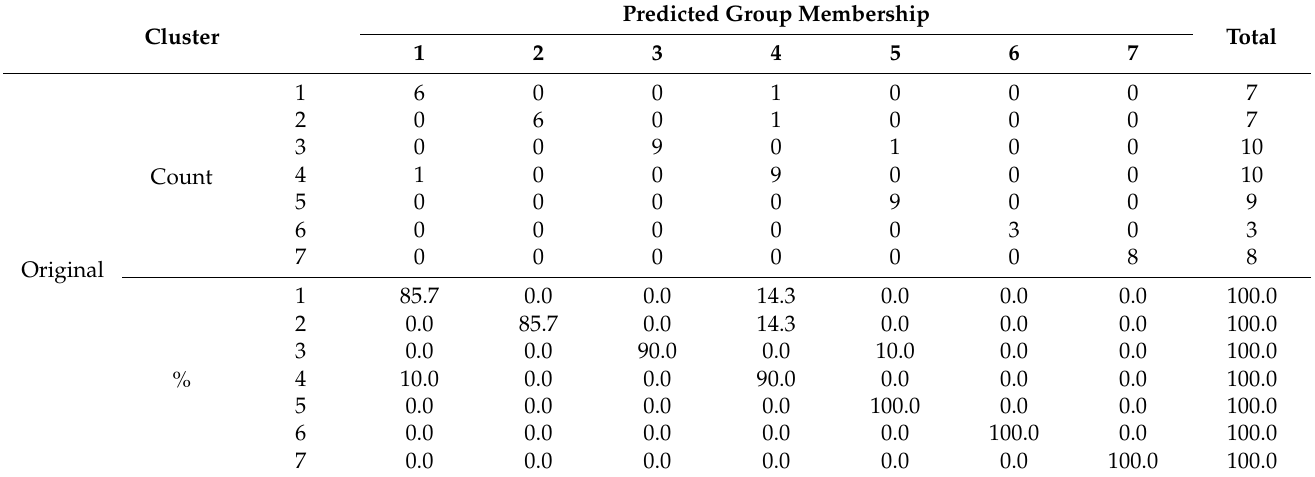
Table 9. Classification